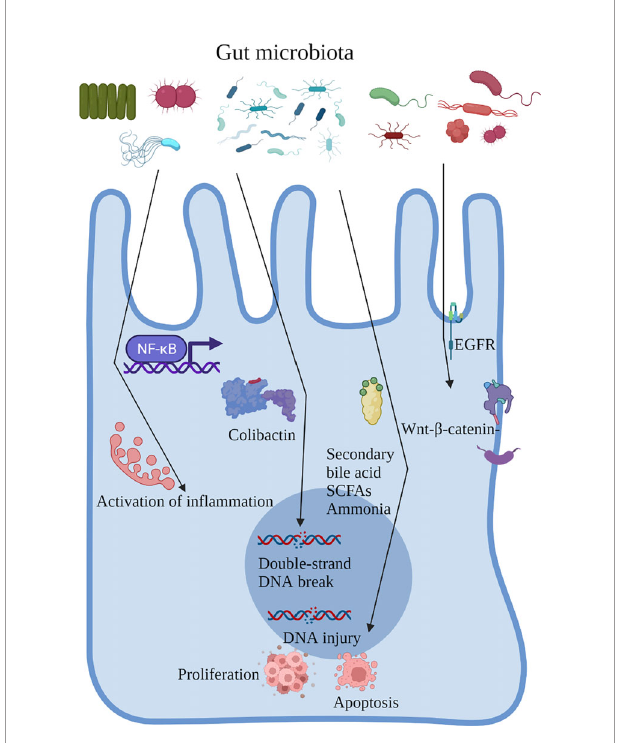
FIGURE 2 | Role of the gut microbiota in the process of CRC and the carcinogenic mechanism of gut microbiota alterations after